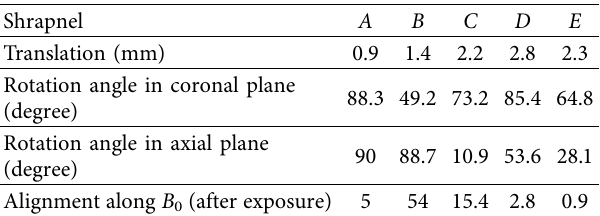
Table 2: Shrapnel translation and rotation.